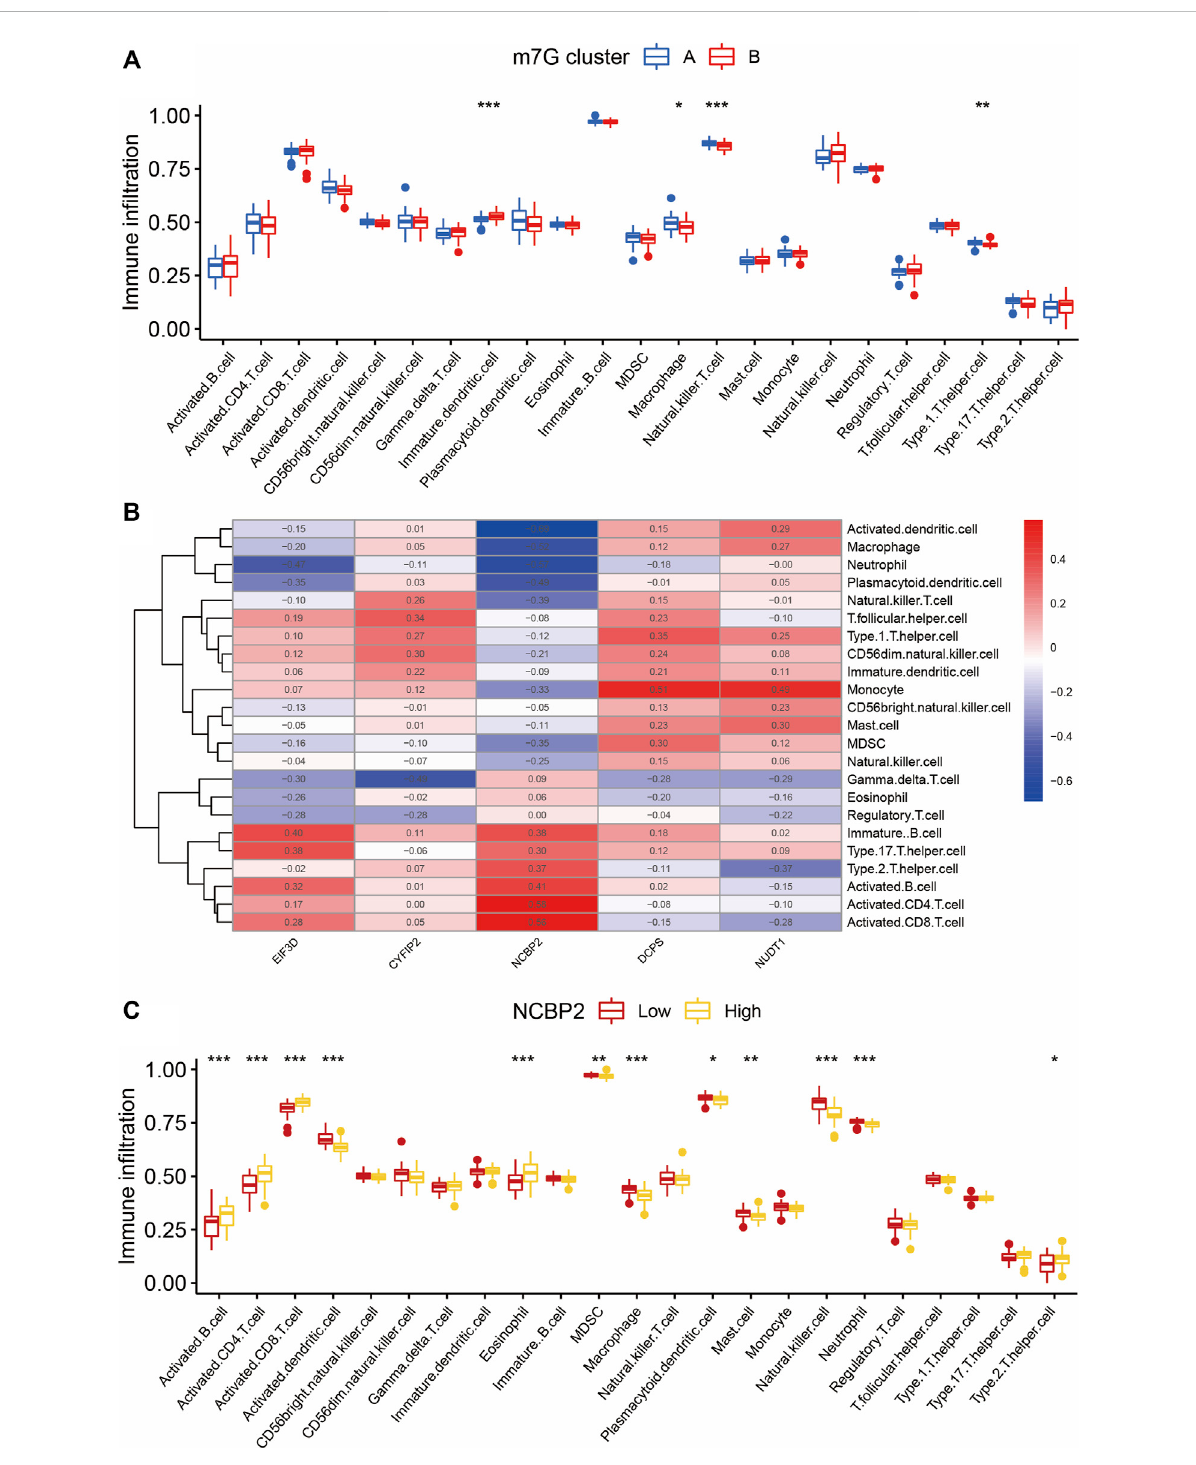
FIGURE 5 Immune in fi ltration analysis of two m7G clusters. (A) Differences in immune in fi ltration abundances between two m7G clusters. Group A and groupBrepresenttwoclustersofISpatientsdividedaccordingtotheexpressionofm7Gkeyregulatorygenes. (B) Immunecellin fi ltrationcorrelation heatmap of m7G key regulatory genes. Red represents positive correlation and blue represents negative correlation. (C) Immune in fi ltration analysis between clusters with different NCBP2 expression levels. Group Low and group High represent cell clusters with low and high NCBP2 expression, respectively. * p < 0.05, ** p < 0.01, *** p < 0.001. IS: ischemia